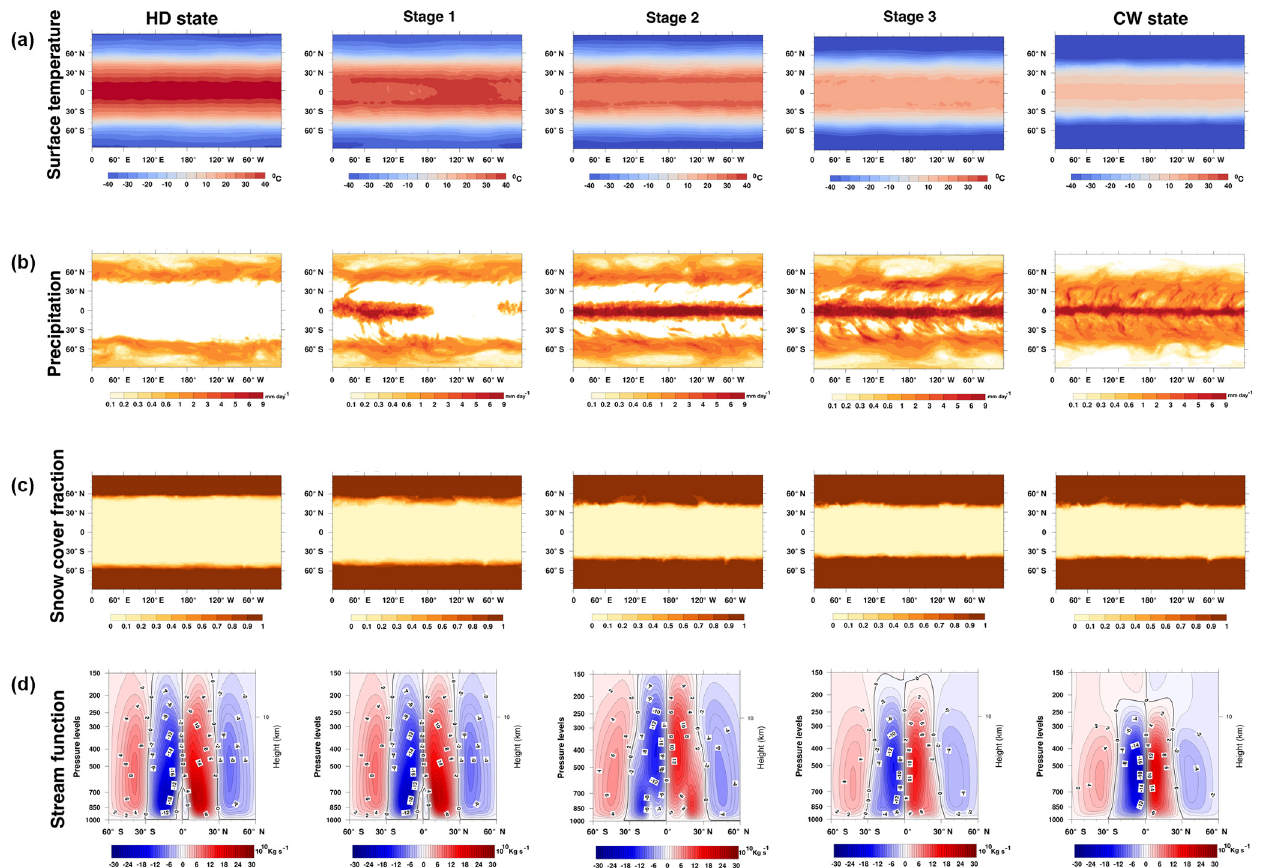
Figure 6. Annual mean surface temperature (a) , precipitation (b) , snow cover fraction (c) , and meridional stream function (d) for different stages of the transition (TRANS simulation) from the HD state to the CW state.